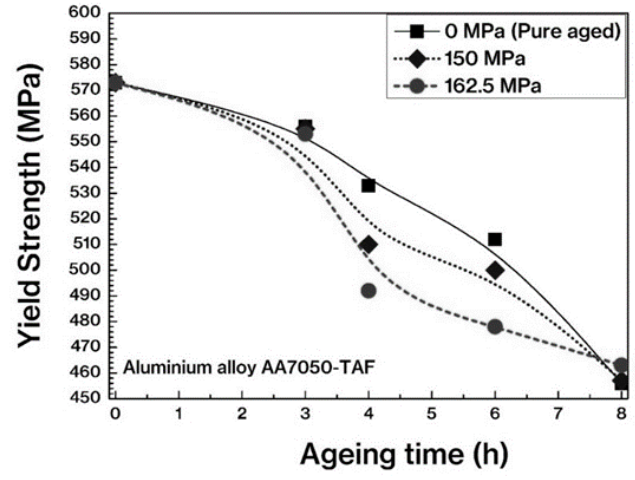
Figure 3. Yield strength of pure/creep aged specimens vs. time.